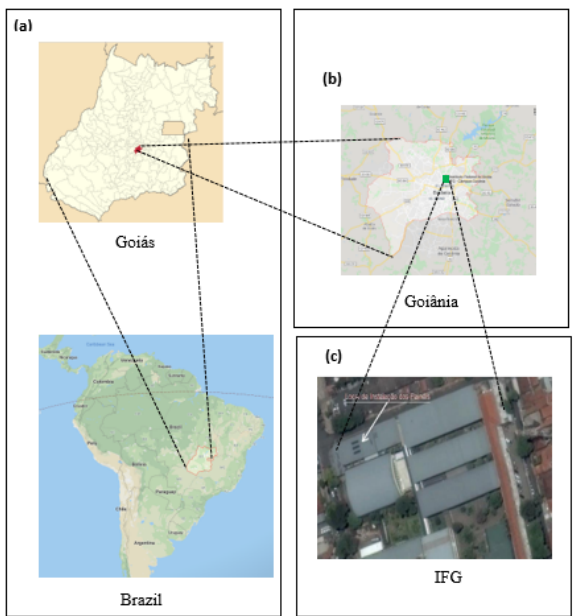
Figure 1. (a) Location of Goi´as State within the Brazilian territory, (b) Location of IFG within the city of Goiˆania. (c) Solar plant used for data